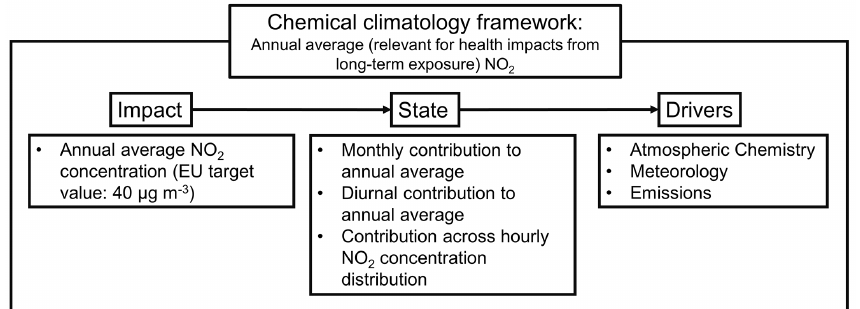
Figure 1. Outline of chemical climatology elements used to evaluate the conditions producing “long-term health-relevant” NO 2 concentra- tions across